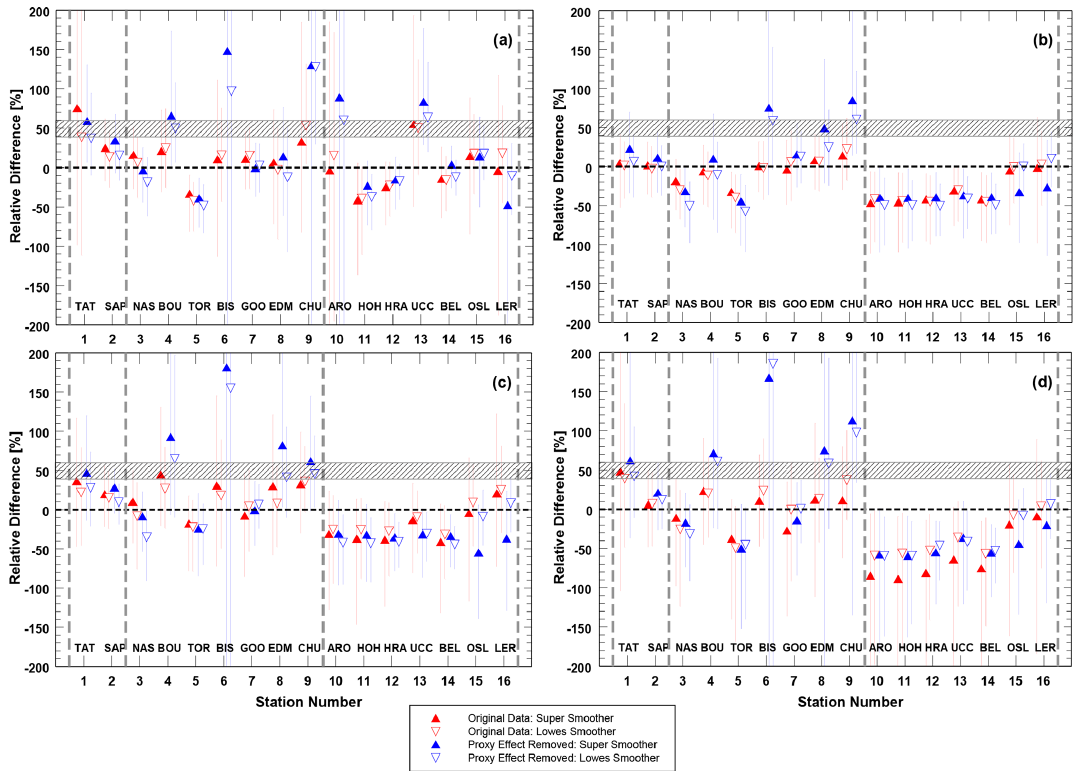
Figure 5. The same as Fig. 4 but for the ozone recovery index, ORI 2 (1997,2020) based on Eq. (2). The reference range (hatched area) is between 40% and 60% according estimates in Sect.